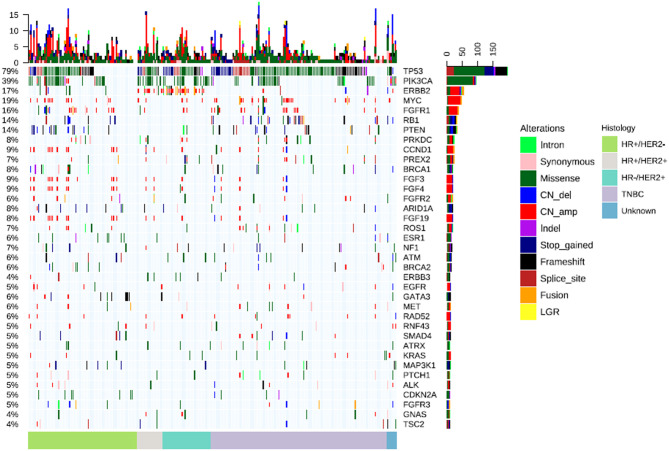
CtDNA mutation profile of the cohort. The bars located at the bottom of the oncoprint denote molecular histology subtypes. Each column represents a patient and each row represents a gene. Values on the left represent the mutation rate of each gene. Values on the right indicate the genes. Top plot represents the overall number of mutations a patient carried. Different colors denote different types of mutation.